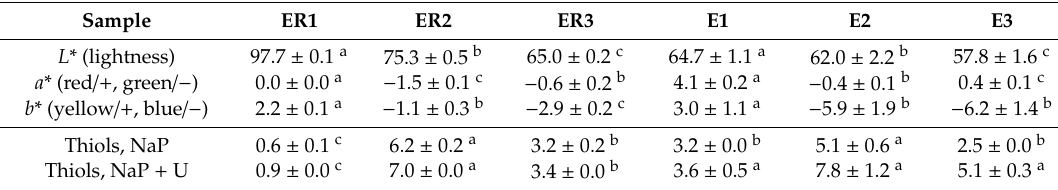
Table 3. Colour values ( L *, a *, b *), free thiol groups (mmol / mg) analysed in sodium phosphate bu ff er with (NaP + U) or without (NaP) urea and cooking properties (before and after cooking) of the extrusion mixtures (ER1–ER3) and extrudates (E1–E3), where 1 indicates pea protein, 2 gutted fish and 3 whole fish. Di ff erent letters (a, b, c) indicate the significant di ff erences ( p < 0.05) within sample groups ER1–ER3 and